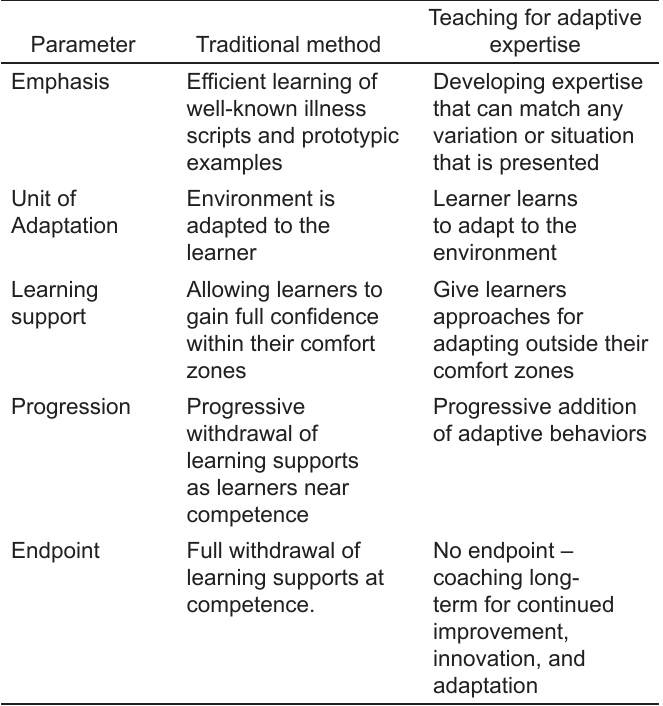
Table 1. A comparison of traditional teaching methodology with teaching for adaptive expertise. Teaching for adaptive expertise may not replace more traditional teaching methods in all cases but ought to be built into emergency medicine training early and often.